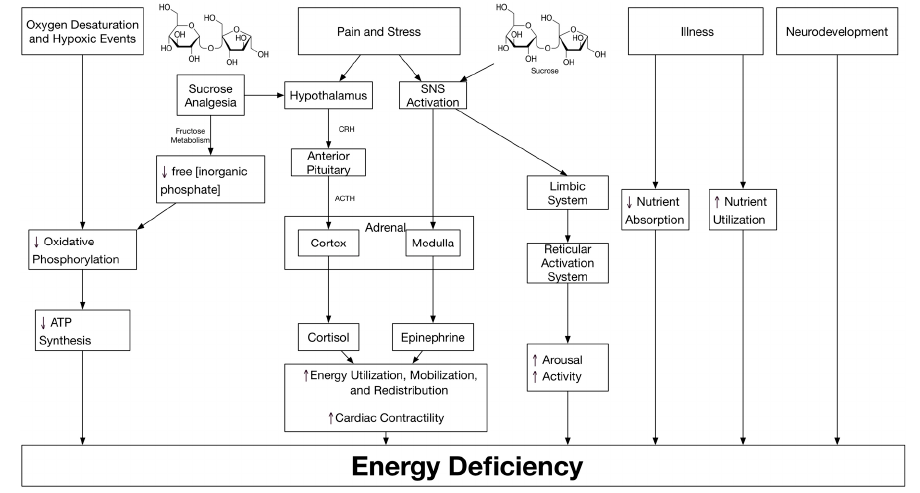
Figure 1. Causes of energy deficiency in the premature infant. (ATP, adenosine triphosphate; SNS, sympathetic nervous system).